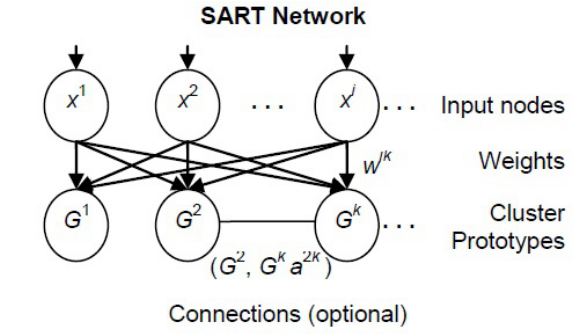
Figure 1: A simplified adaptive resonance theory (SART) network is used to cluster experiences. Input nodes (top layer) represent at- tributes x i of an experience X (such as state or event